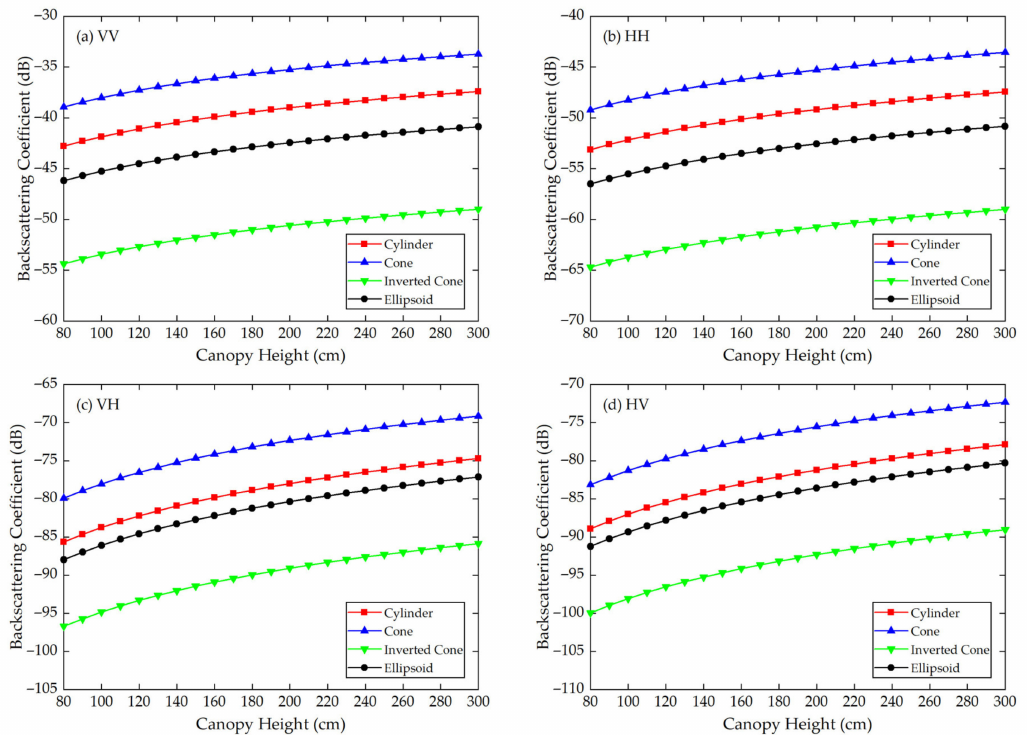
Figure 10. The MTVM simulation results of the backscattering coefficients for different crown shapes in L band (1.2 GHz)